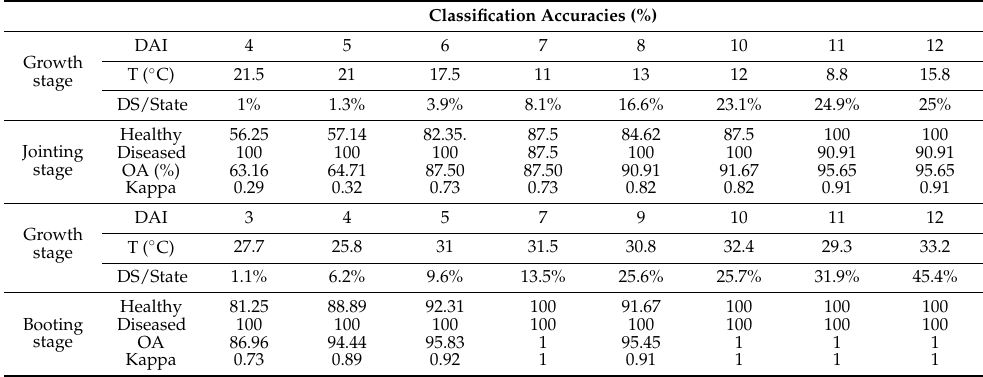
Table 4. PLS-LDA classification results of healthy and diseased leaves based on combined spectral and texture indices (VIs & NDTIs) at the jointing and booting